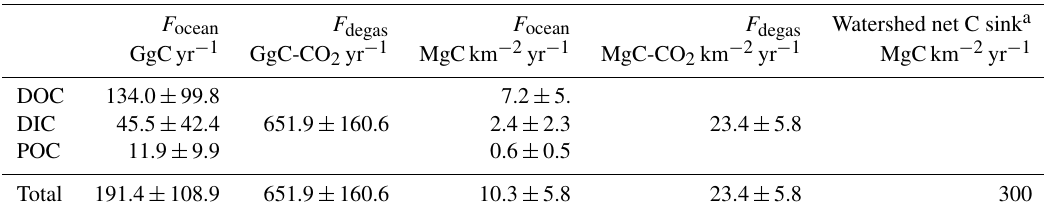
Table 7. At the Nyong watershed scale, averages of monthly hydrological export of C to the ocean ( F ocean ) and of monthly CO 2 degassing to the atmosphere ( F degas )